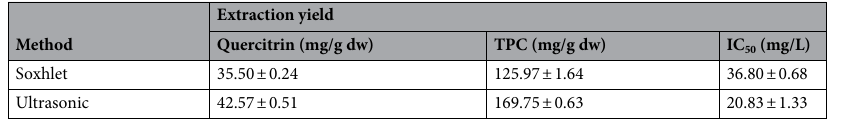
Table 5. Comparison of extraction yield between ultrasonic and Soxhlet extraction methods. Values are presented as mean ± SD (n =